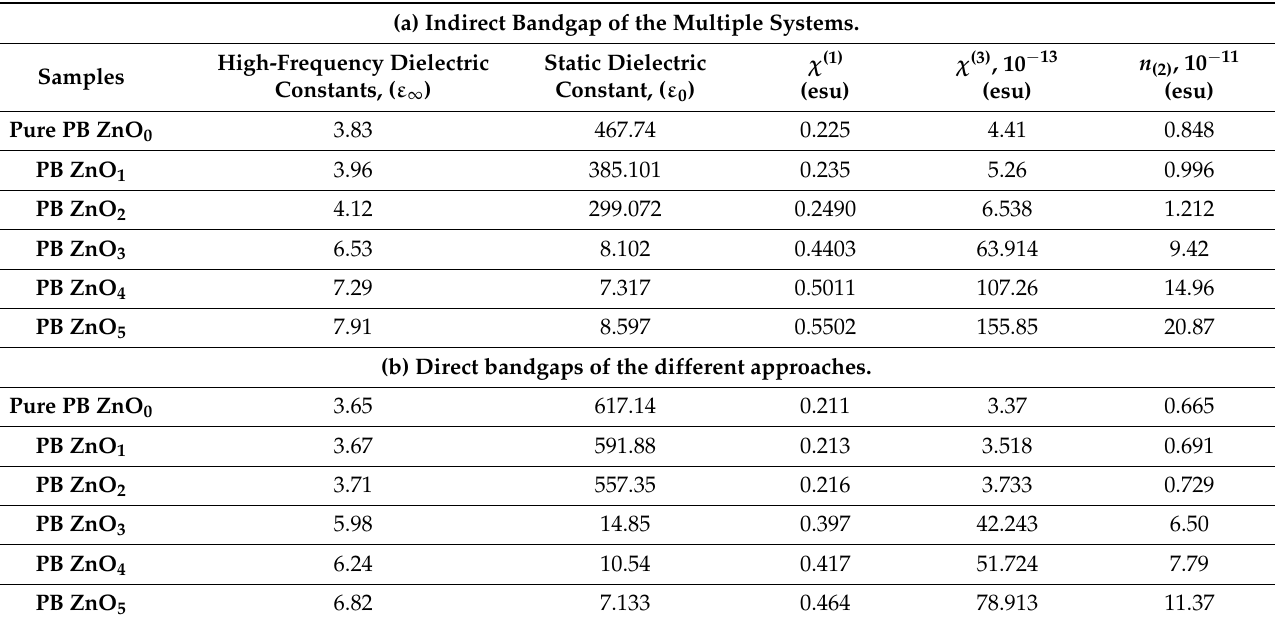
Table 4. The nonlinear calculated optical values for the indirect bandgap of the various systems. (a) Indirect Bandgap of the Multiple